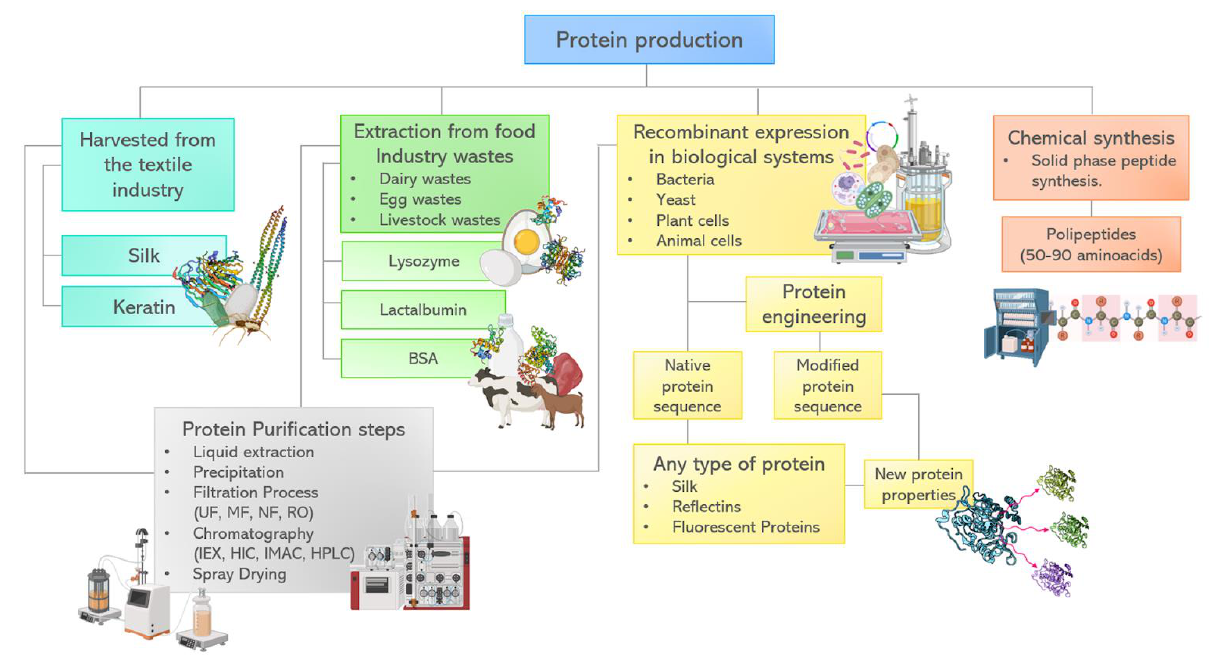
Figure 4. Protein extraction or production process alternatives and methods of